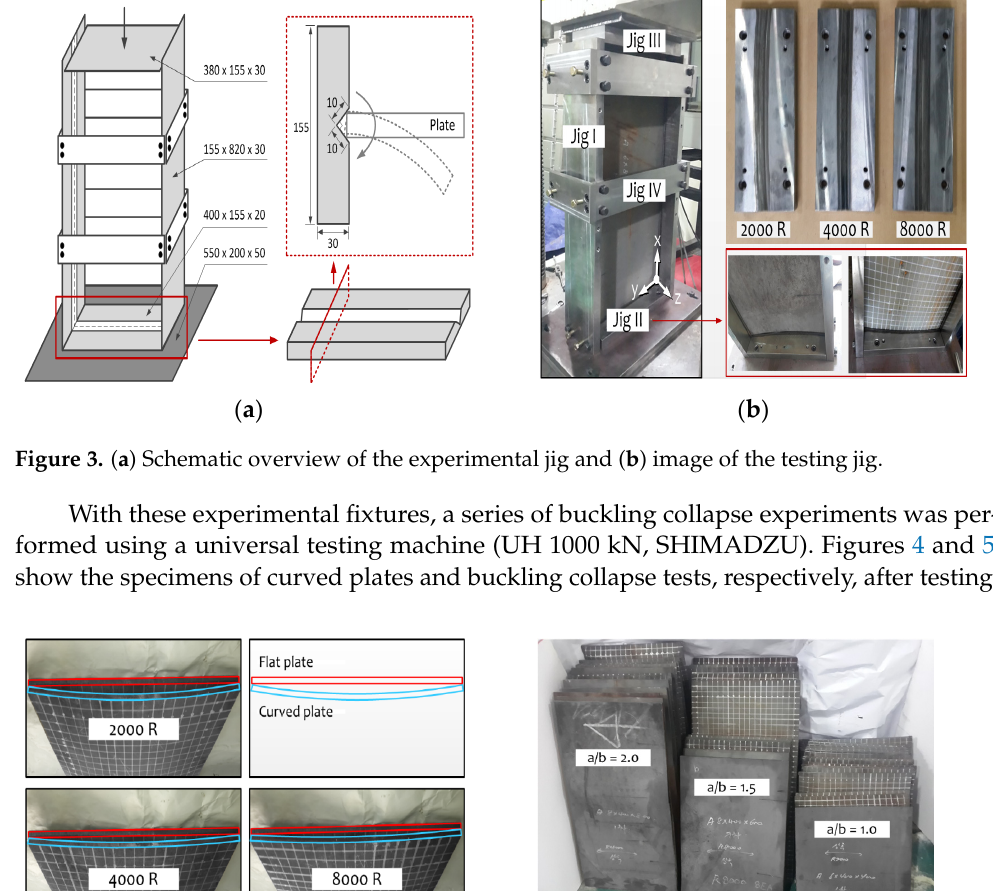
Figure 5. Buckling collapse test for curved plates.